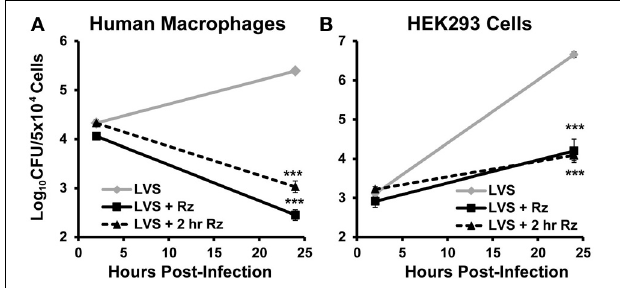
FIGURE 4 | Resazurin exhibits antimicrobial activity on intracellular F. tularensis LVS. Primary human macrophages (A) or HEK293 (B) cells were infected with F. tularensis LVS bacteria using a gentamicin protection assay. Cells were treated with 44 µ M resazurin during the entire assay ( + Rz), at 2h post-infection ( + 2h Rz), or were untreated. Data shown are mean ± s.e.m. and representative of three independent experiments. The limit of detection was 100 CFU. Statistically significant differences in growth at 24h post-infection were determined by Two-Way ANOVA with Dunnett’s post-hoc test ( ∗∗∗ p < 0 .